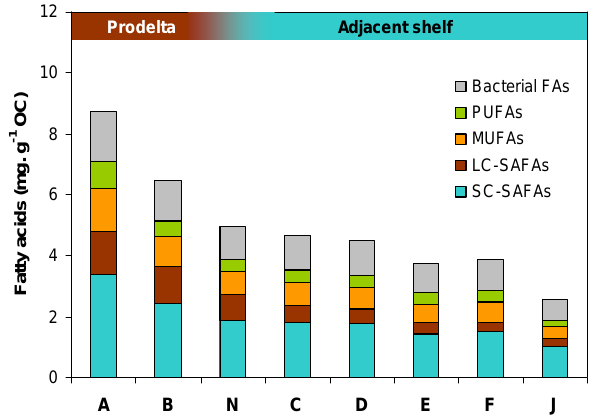
Fig. 4. Contribution of bacterial, polyunsaturated, monounsatu- rated, long chain saturated and short chain saturated fatty acids to the sedimentary organic matter (mgg − 1 OC). Fatty acids were grouped as follows: Bacterial FAs=odd numbered saturated FAs; iso and anteiso FAs and vaccenic acid; PUFAs=C 16 to C 22 polyunsaturated FAs; MUFAs=16:1 ω 7, 18:1 ω 9, 20:1 ω 9; SC- SAFAs ≤ C 20 even numbered saturated FAs; LC-SAFAs > C 20 even numbered saturated